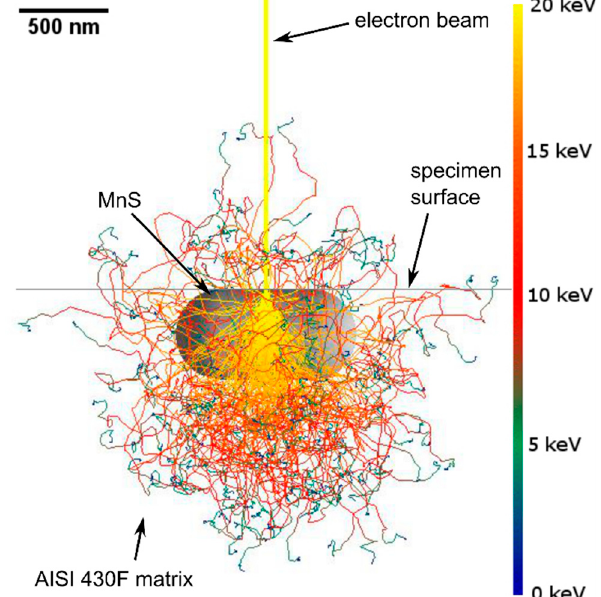
Figure 9. Monte Carlo Simulation of electron trajectory in MnS inclusion and AISI 430F (X12CrMoS17) matrix.